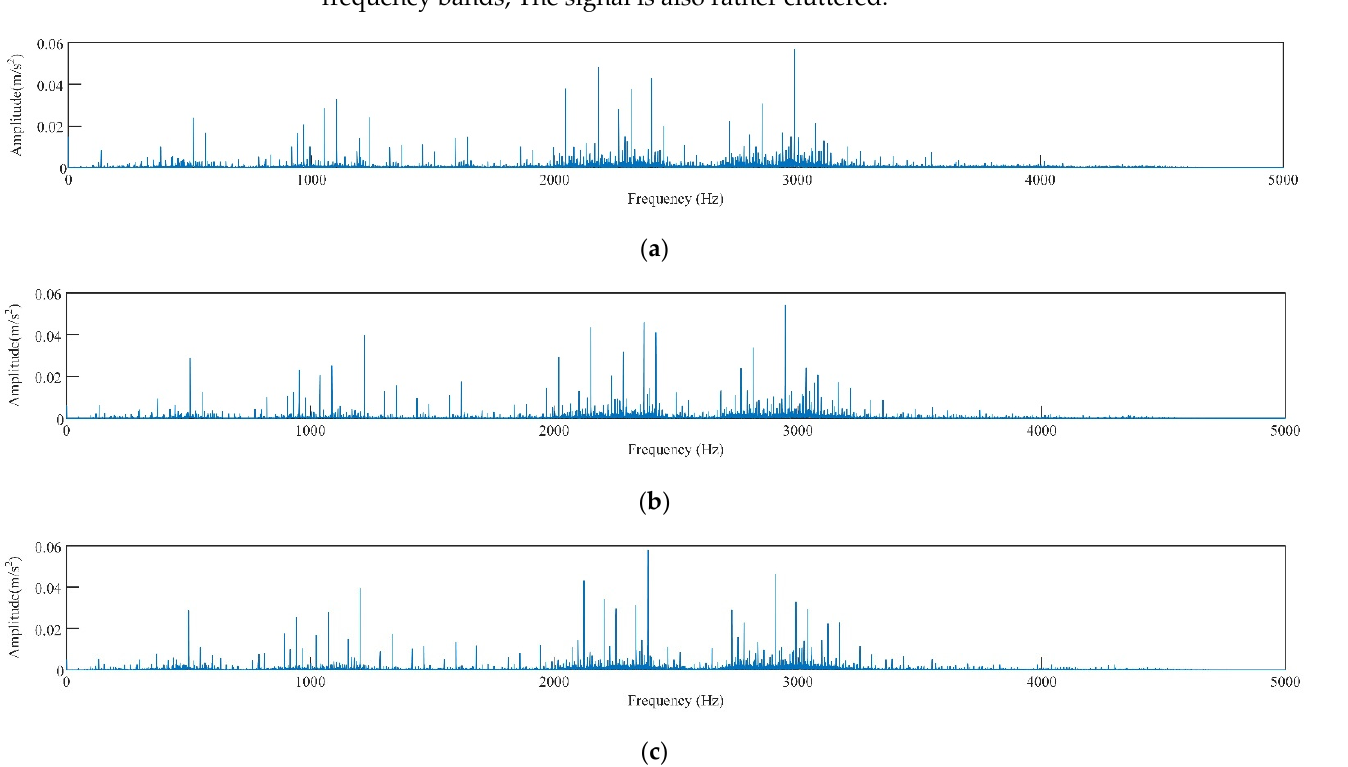
Figure 5. Time domain diagram of vibration signals of different types of rolling bearings, ( a ) 0HP load normal, ( b ) 0HP load inner ring fault diameter is 0.1778 mm, ( c ) 1HP load inner ring fault diameter is 0.1778 mm, ( d ) 2HP load inner ring fault diameter is 0.1778 mm, ( e ) 0HP load inner ring fault diameter is 0.3556 mm, ( f ) 0HP load inner ring fault diameter is 0.5334 mm, ( g ) 0HP load outer ring fault diameter is 0.1778 mm, ( h ) 0HP load rolling element fault diameter is 0.1778 mm.